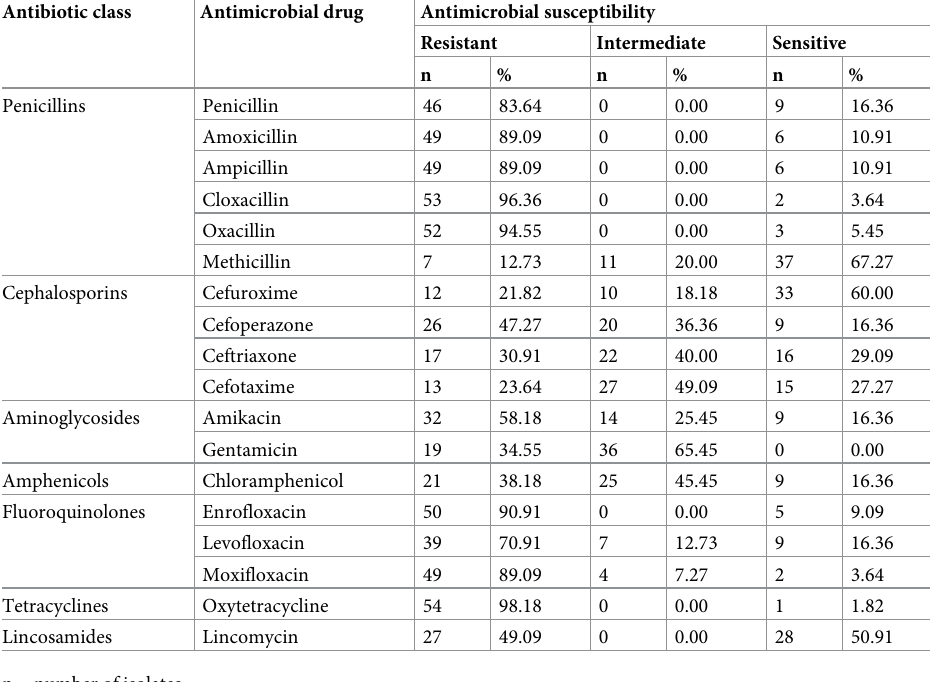
Table 3. Antimicrobial susceptibility of S . aureus (n = 55) isolated from clinical cases of cattle. Antibiotic class Antimicrobial drug Antimicrobial susceptibility